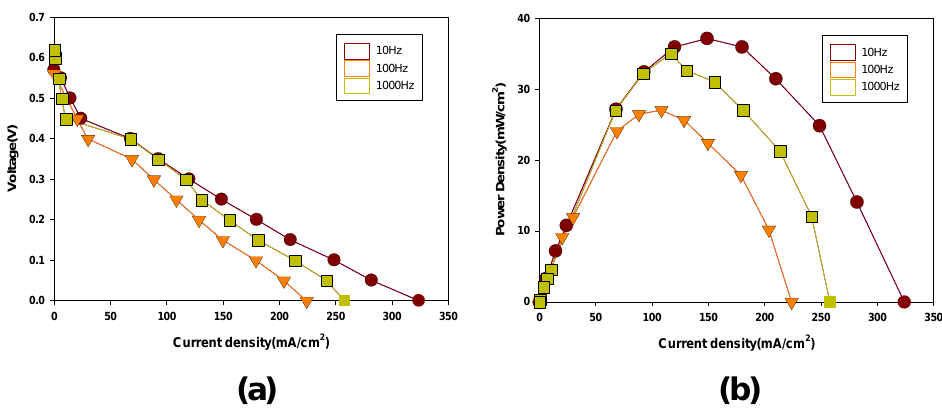
Figure 7. ( a ) Voltage and ( b ) power density as a function of current density for DMFCs with Au coated PCB substrates using the pulse electroplating method formed at various frequencies.